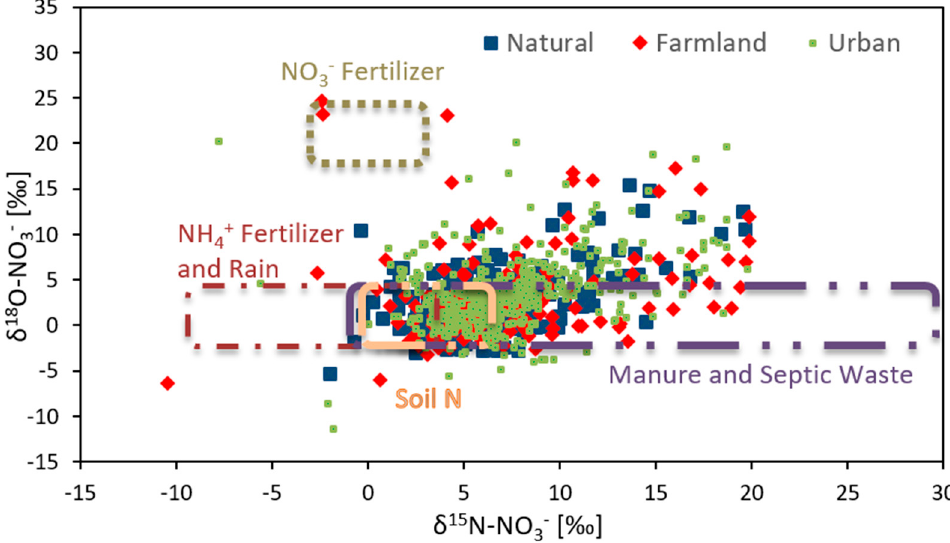
Figure 7. Dual nitrate isotope plot with samples grouped by land use. Source fields are modified from Kendall, 1998. Ranges for synthetic fertilizer δ 15 N are lower due to the atmospheric N source,